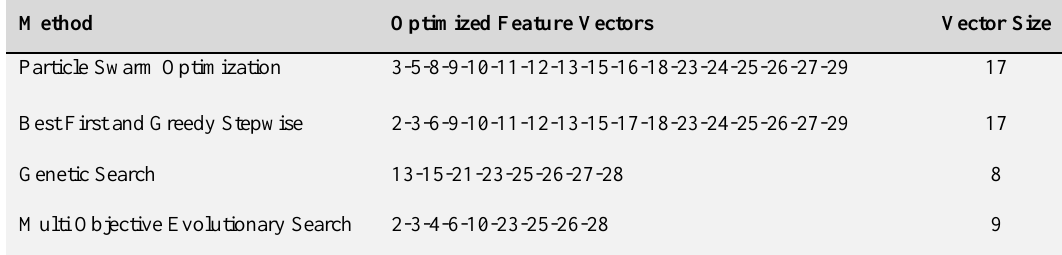
Table 3. Optimized feature vectors and selected features.